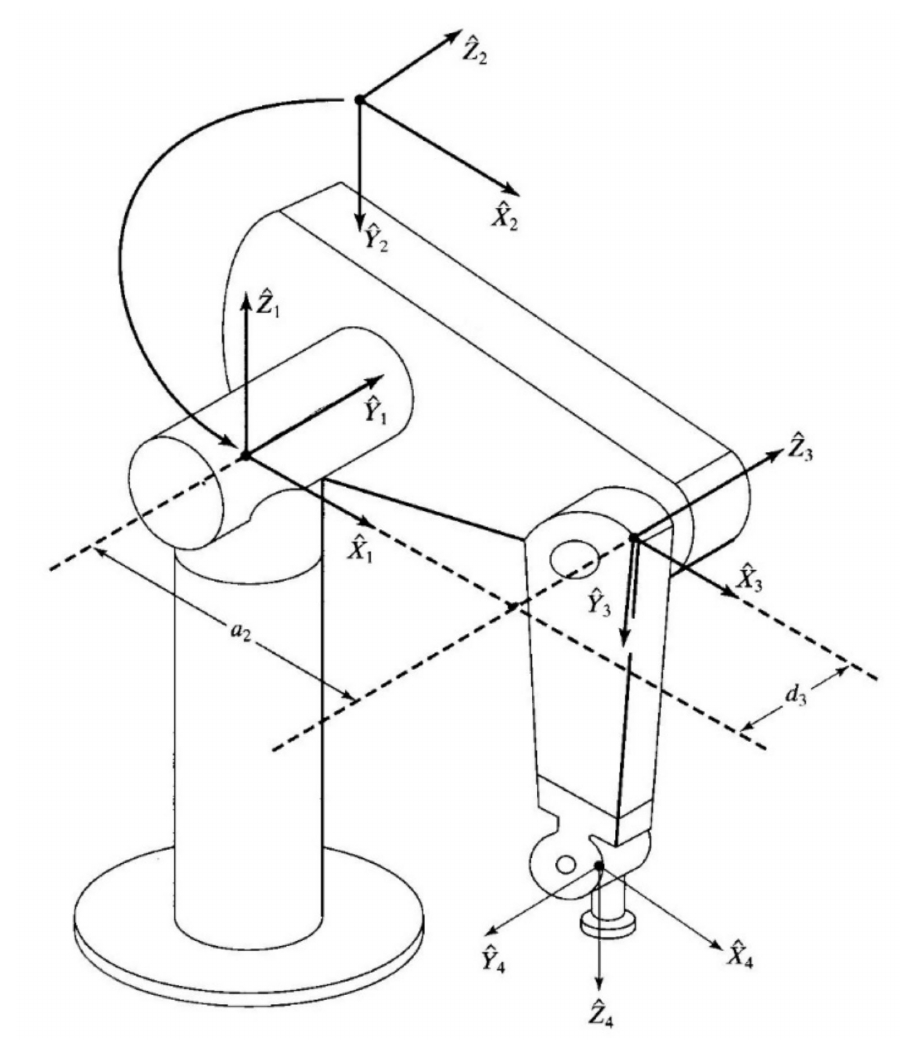
Figure 2. Structure of the PUMA560 robot